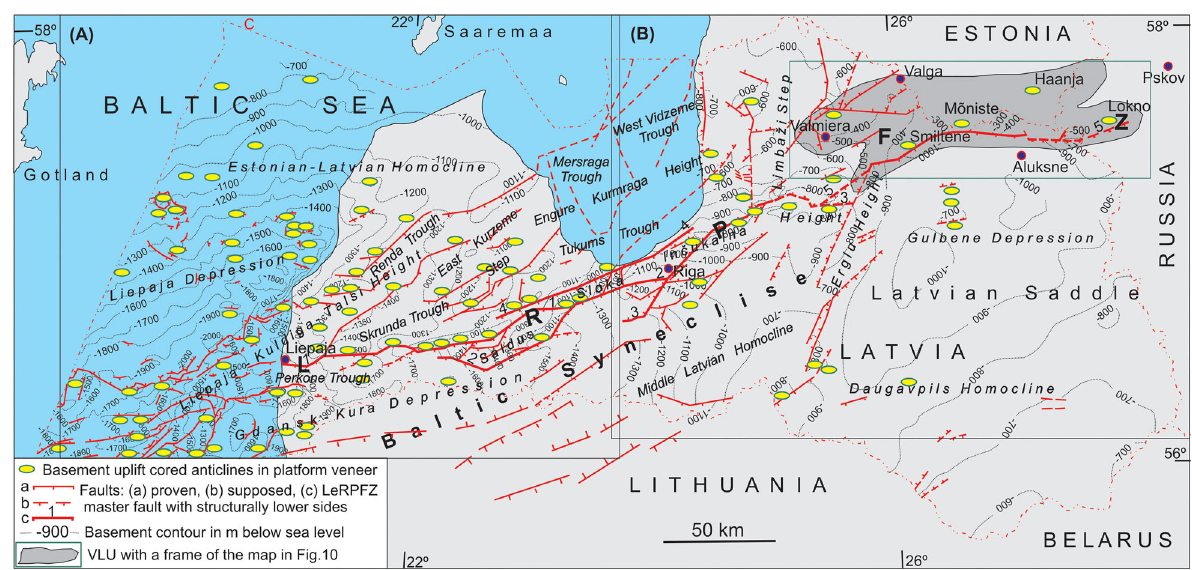
Fig. 2. Structure contour map on top of the crystalline basement in Latvia with the Liepaja–Riga–Pskov Fault Zone (LRPFZ) and names of structural units (heights, troughs, etc.) induced by basement faulting (modified after Brio et al. 1981; Brangulis & Kanev 2002). Frames A and B – enlargements of maps shown in Fig. 9A, B, respectively. Numbered master faults of the LeRPFZ: